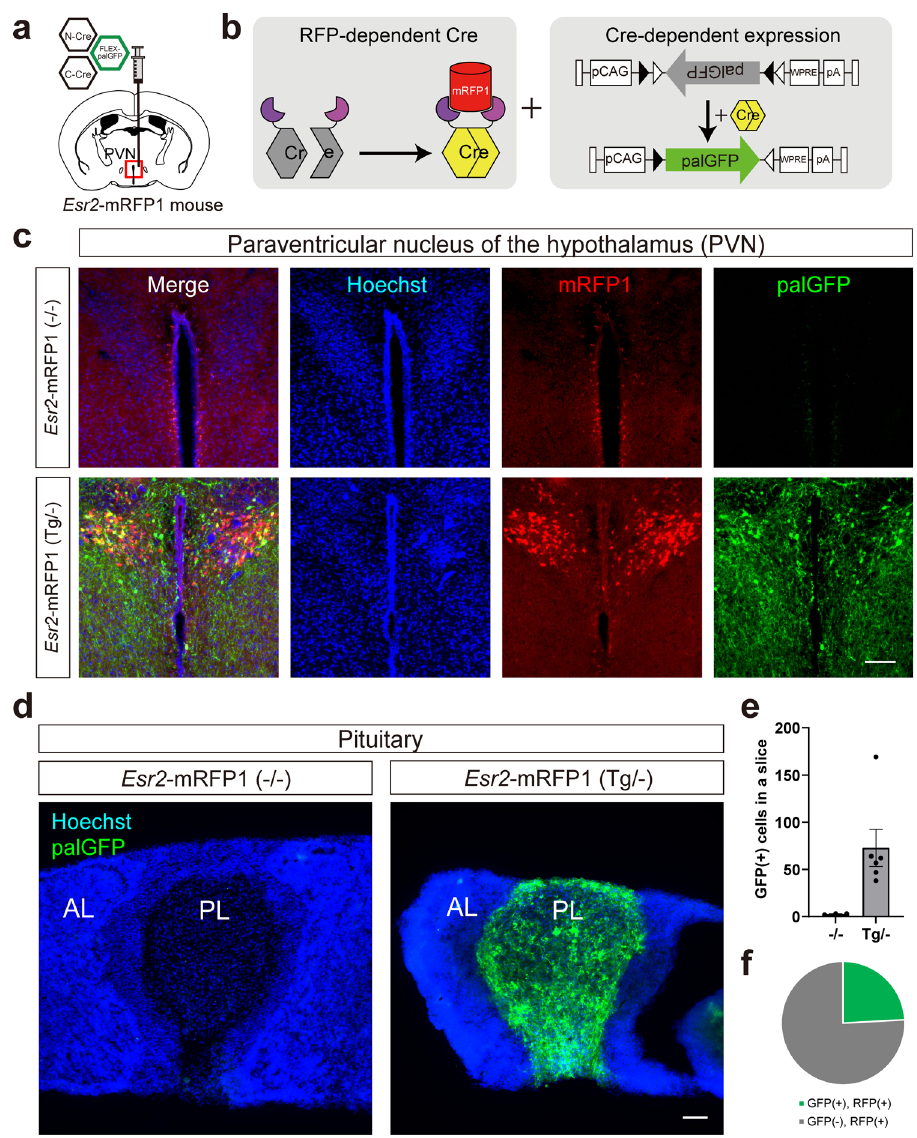
Fig. 5 Anterograde tracing using Cre-DOR in Esr2 -mRFP1 transgenic mice. a Stereotaxic injection schema of Cre-DOR N6C1 in Esr2 -mRFP1 transgenic mice. Three kinds of virus (NCre-MBP6, CCre-MBP1, FLEX-palGFP) were injected in the paraventricular nucleus (PVN). b Schematic representation of speci fi c expression of palGFP induced by Cre-DOR activated by mRFP1. c Immuno fl uorescent images of the PVN of injected mice. Scale bar = 100 μ m. d Representative images of axonal projection from palGFP-expressing neurons in the PVN of Esr2 -mRFP1 transgenic mice. AL anterior lobe, PL posterior lobe. Scale bar = 100 μ m. e Quanti fi cation of mRFP1-induced expression of palGFP in WT and Tg Esr2 -mRFP1 mice . f Cell counting results showing the average percentage of palGFP-positive cells in the PVN of the Cre-DOR virus-injected Esr2 -mRFP1 transgenic